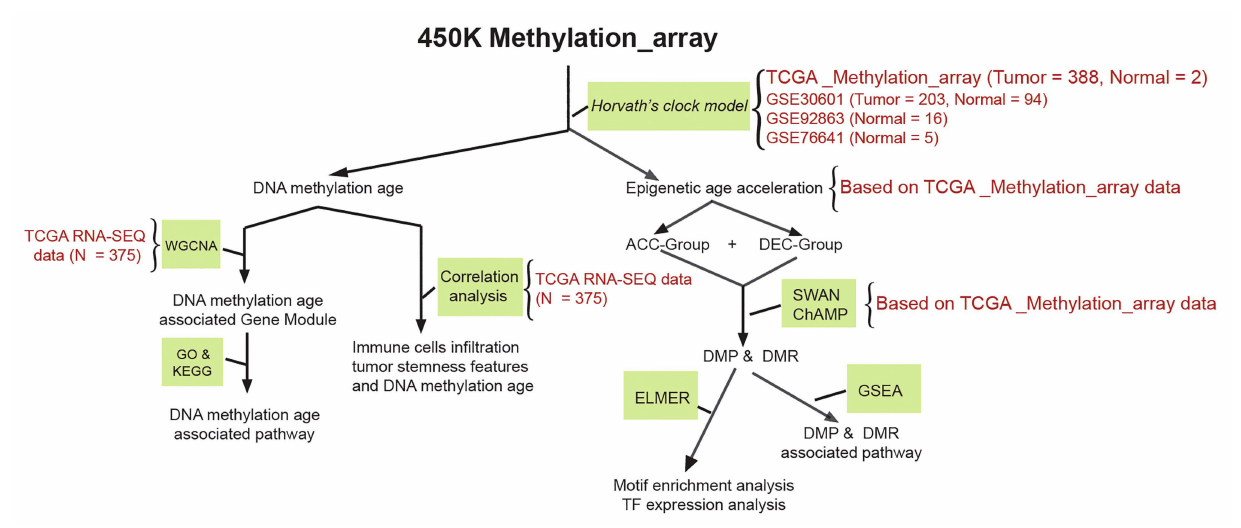
FIGURE 1 | Schematic of the study method. Methylation array data of stomach adenocarcinoma (STAD) and normal stomach were downloaded from The Cancer Genome Atlas (TCGA) and gene expression omnibus (GEO) database. TCGA_Methylation_array, GSE30601, GSE92863, and GSE76641 datasets were used to calculate DNAm age based on a Horvath’s clock model; TCGA RNA-SEQ data were used to identify DNAm age related gene module based on WGCNA; relationship between DNAm age and immune cell infiltration profiles of STAD patients calculated by TCGA RNA-SEQ data were evaluated by correlation analysis; epigenetic age acceleration of STAD patients, DMP, and DMR were calculated based on TCGA_Methylation_array data. STAD, stomach adenocarcinoma; TCGA, The Cancer Genome Atlas; GEO, the gene expression omnibus; DMP and DMR, differential methylated probes and differential methylated regions; ACC, DNAm age accelerated group; DEC, DNAm age decelerated group; GSEA, gene set enrichment analysis; ELMER, enhancer linking by methylation/expression